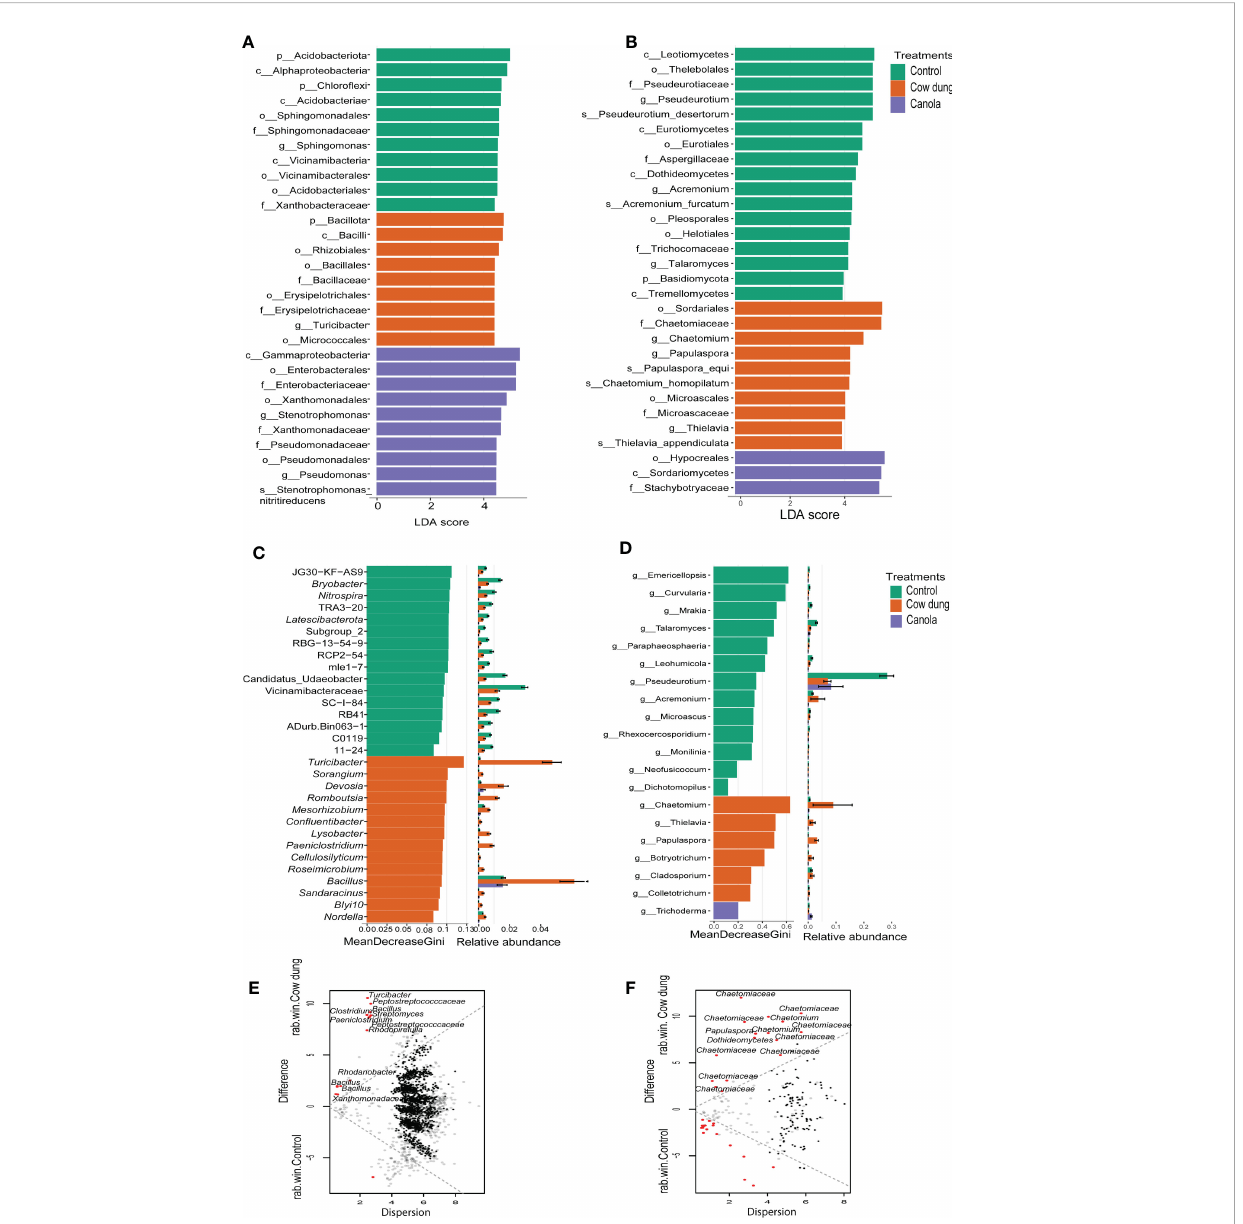
FIGURE 3 Differential abundance analysis of bacterial and fungal taxa after soil amendments. LEfSe analysis (LDA score > 4.0) displaying differentially abundant bacterial (A) and fungal (B) taxa among the treatments. Taxon names are abbreviated as p: phylum, c: class, o: order, f: family, and g: genus. Random forest model displaying the most predictive bacterial (C) and fungal (D) genera following soil amendments. Bland-Altman plot showing ALDEx2 analysis between cow dung and control of bacteria (E) and fungi (F) . ASVs with a larger difference and small dispersion are considered differentially abundant (q ≤ 0.1) and are indicated by red dots. Black and grey dots represent rare and abundant taxa,